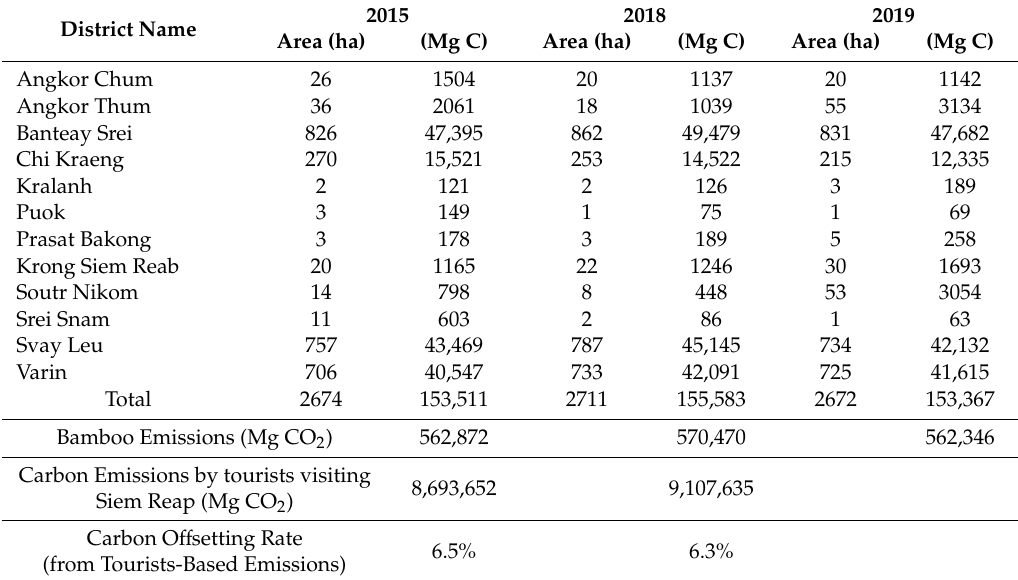
Table 4. Total carbon stocks and emission reductions in bamboo forests by districts in Siem Reap Province in 2015, 2018, and 2019.